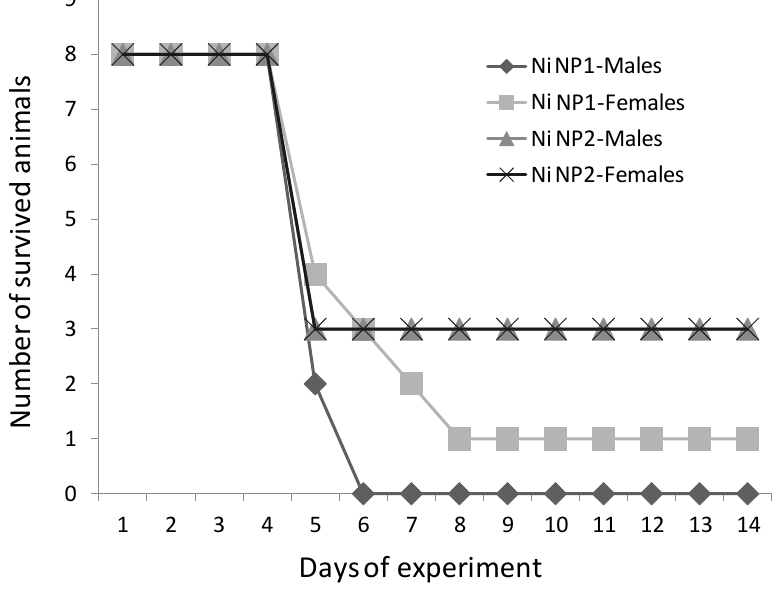
Figure 3. The survival rate of male and female rats within 14 days after a single intragastric administration of Ni NPs at a dose of 2000 mg/kg b.w.